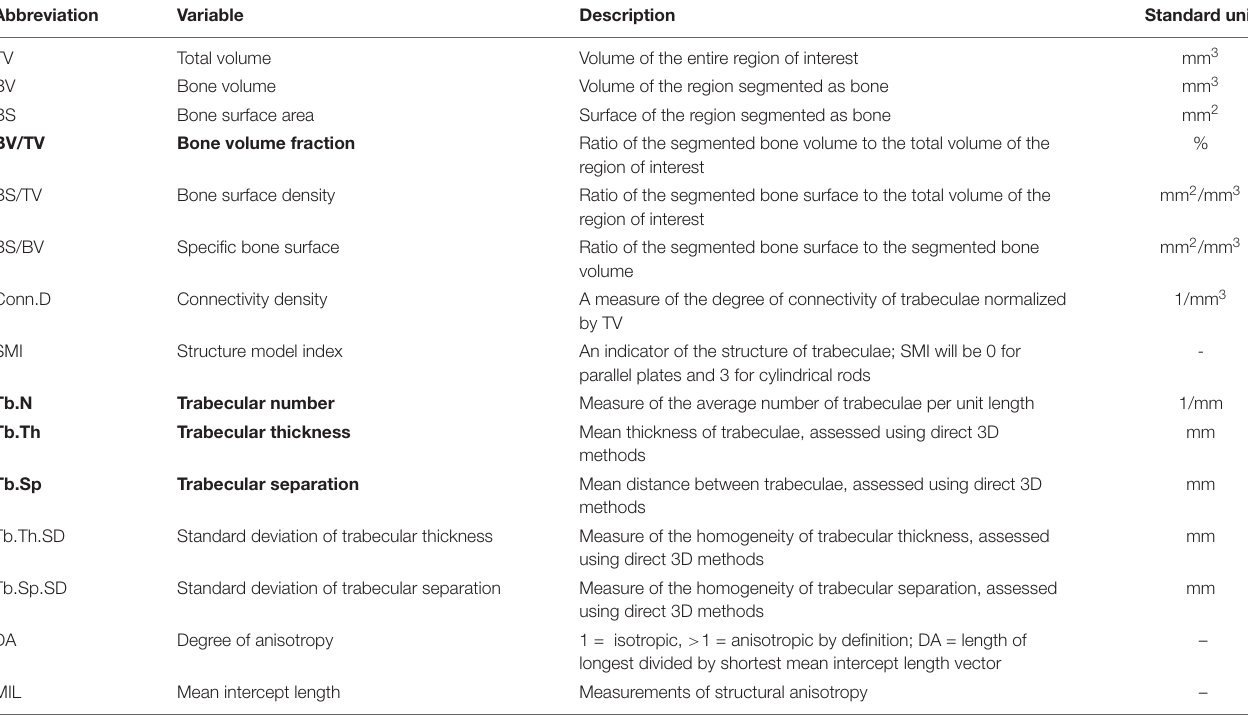
TABLE 3 | Definitions and descriptions of bone morphometric